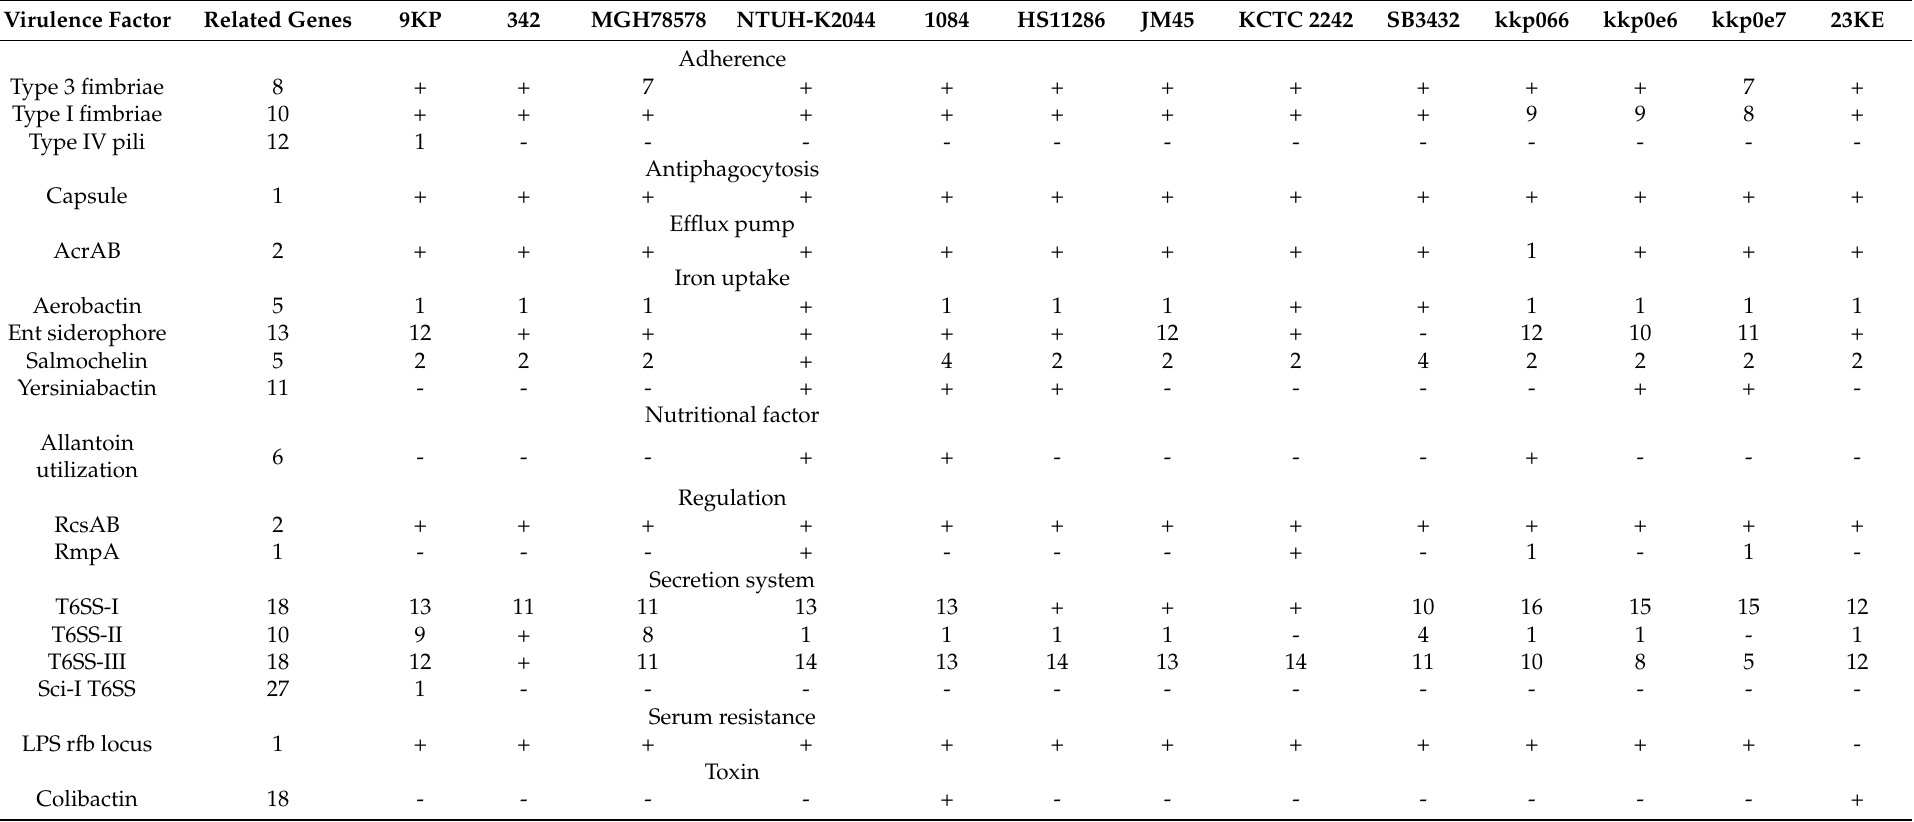
Table 2. Comparison of virulence factors of K. pneumoniae 9KP with other control strains ( K. pneumoniae 342, MGH 78578, NTUH-K2044, 1084, HS11286, JM45, KCTC 2242, SB3432) and the most related strains (kkp066, kkp0e6, and